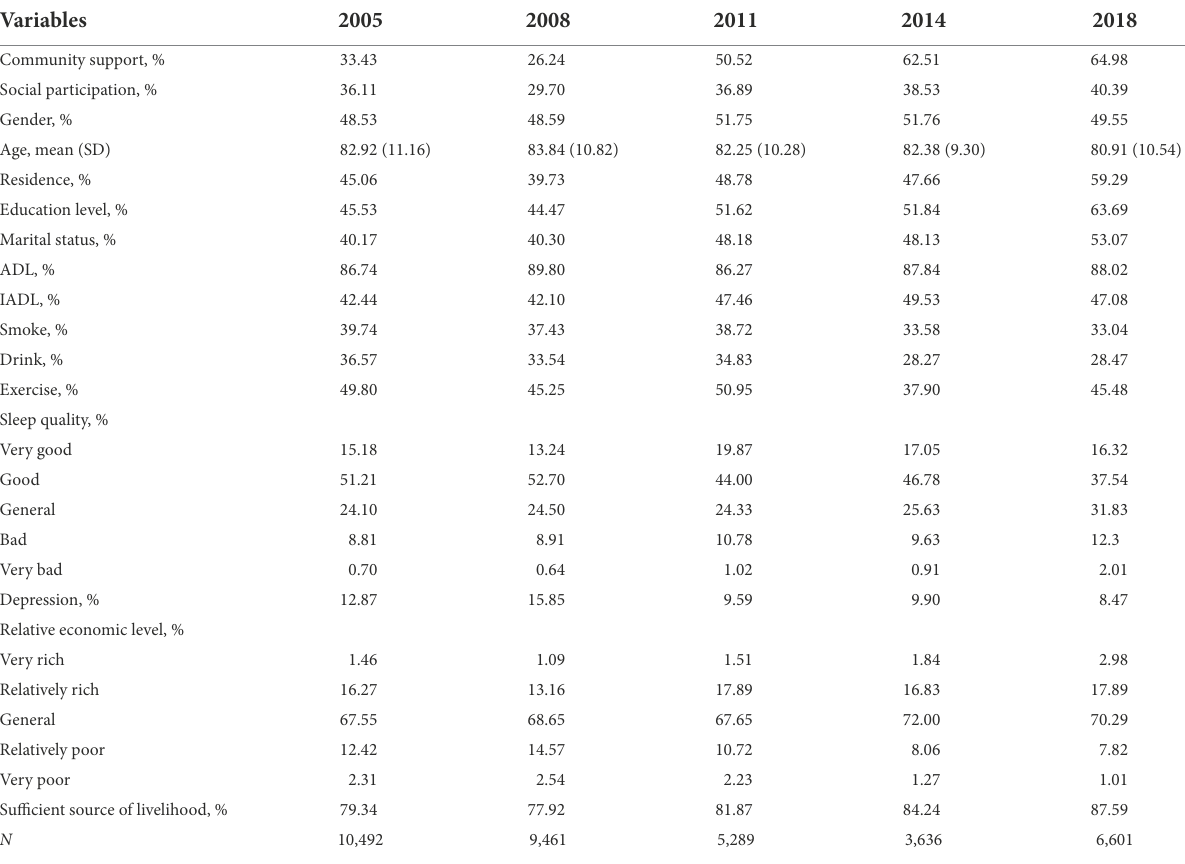
TABLE 1 Sample characteristics (five periods pooled